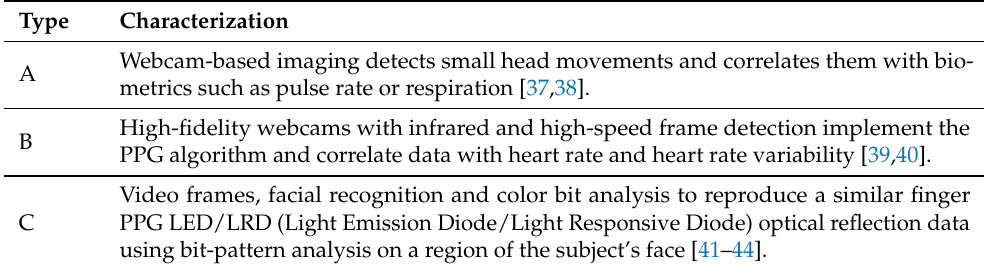
Table 1. Video-based stress detection